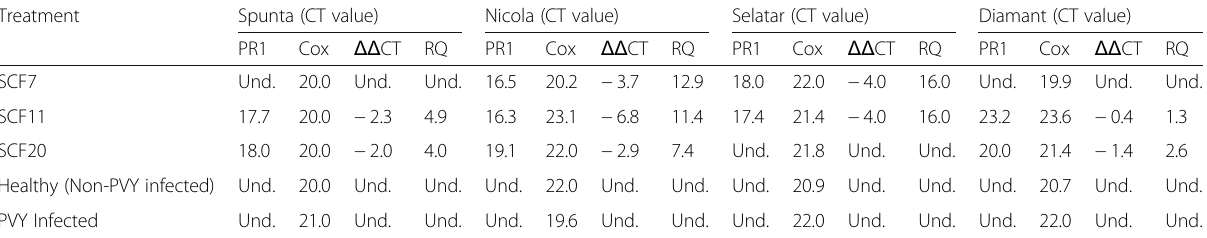
Table 1 Expression of PR1-b gene in different potato cultivars after application of different SCF under greenhouse conditions. Treatment Spunta (CT value) Nicola (CT value) Selatar (CT value) Diamant (CT value) PR1 Cox ΔΔ CT RQ PR1 Cox ΔΔ CT RQ PR1 Cox ΔΔ CT RQ PR1 Cox ΔΔ CT RQ SCF7 Und. 20.0 Und. Und. 16.5 20.2 − 3.7 12.9 18.0 22.0 − 4.0 16.0 Und. 19.9 Und. Und. SCF11 17.7 20.0 − 2.3 4.9 16.3 23.1 − 6.8 11.4 17.4 21.4 − 4.0 16.0 23.2 23.6 − 0.4 1.3 SCF20 18.0 20.0 − 2.0 4.0 19.1 22.0 − 2.9 7.4 Und. 21.8 Und. Und. 20.0 21.4 − 1.4 2.6 Healthy (Non-PVY infected) Und. 20.0 Und. Und. Und. 22.0 Und. Und. Und. 20.9 Und. Und. Und. 20.7 Und. Und. PVY Infected Und. 21.0 Und. Und. Und. 19.6 Und. Und. Und. 22.0 Und. Und. Und. 22.0 Und. Und. Represent the expression level of PR1-b gene as detected at two time intervals; 7 days after virus inoculation (DAVI) (not expressed) and 21 DAVI (current table) The foliar spraying of potato cultivars using different Streptomyces crude filtrates at 7 DBVI and also 7 DAVI Represent culture filtrates of Streptomyces netropsis DSM 40093 (SCF7), Streptomyces ambofaciens (SCF11), and Streptomyces actuosus (SCF20) CT value is the PCR cycle number at which the curve intersects the threshold (horizontal line), where fluorescence meets the threshold in the amplification plot. Undetected was considered negative result, cycle threshold Ct > 30 considered negative while, Ct < 30 considered positive result. PR1: gene encoding for pathogenesis related protein. Cox: encoding for cytochrome oxidase of potato (reference gene). Und: undetected. Data were collected from the mean values of Ct of two replicated run by real time PCR and the whole experiment was conducted